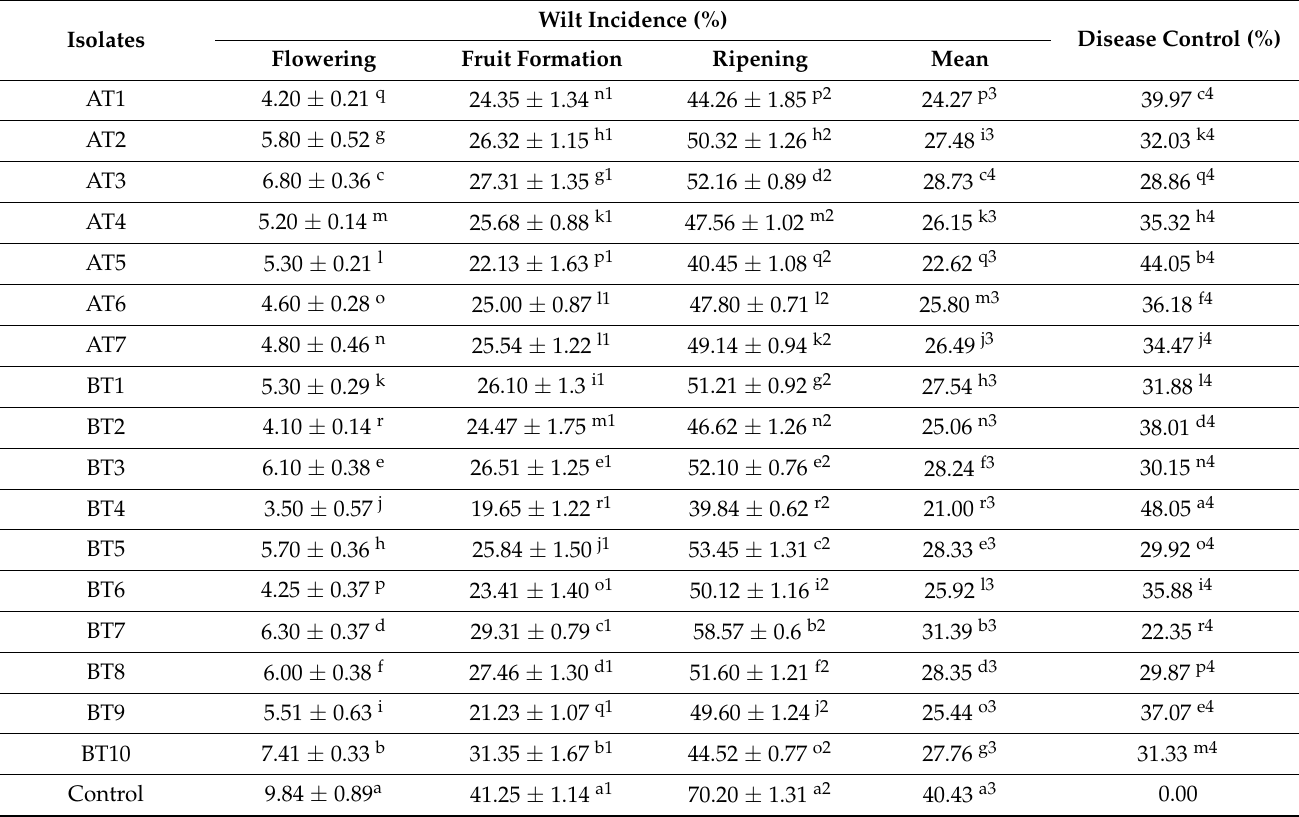
Disease Control (%)